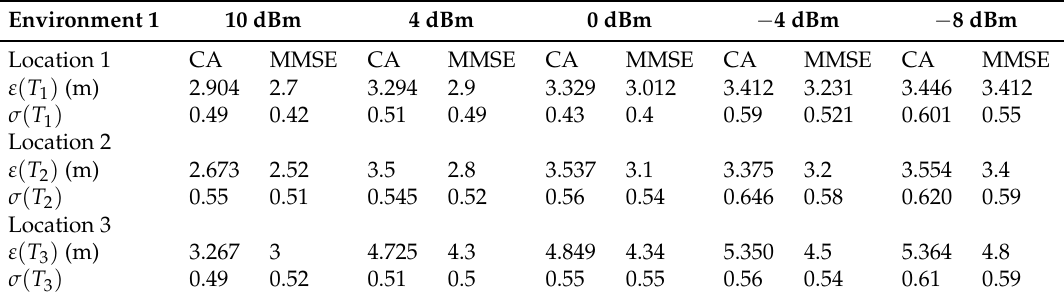
Table 5. Localization Accuracy and Localization Precision in Environment 1.